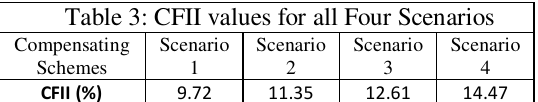
Fig.5: Temporary Overvoltages (pu) Vs Statcom Capacity Mvar (Scenario 3 and 4)